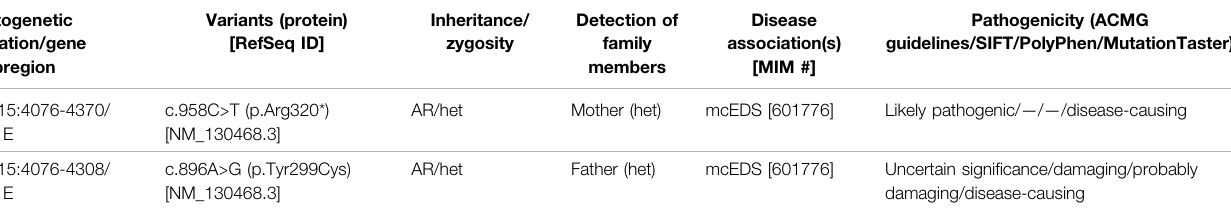
TABLE 1 | Two mutations identi fi ed in the CHST14 gene.